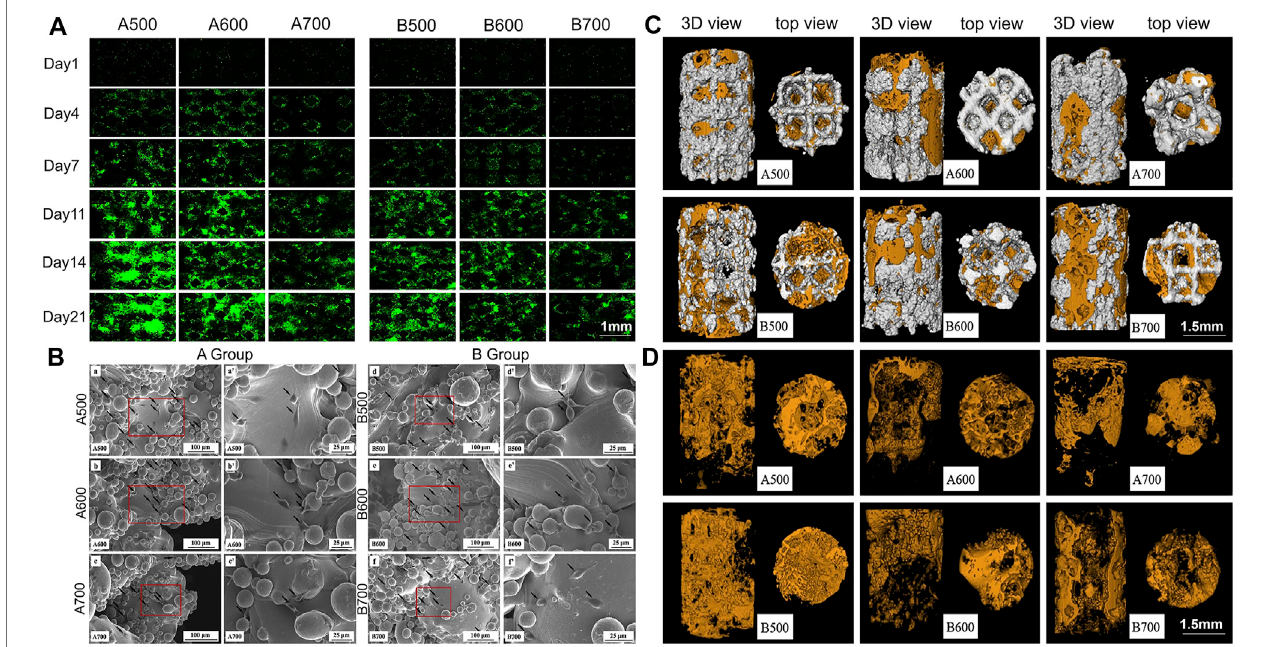
FIGURE 3 | (A) Fluorescent images showing cell proliferation on the porous scaffolds. (B) Scanning electron microscopy (SEM) observation of rat BMSCs. Black arrows point to cells. (C) Micro-CT analysis of new bone formation. Reconstruction images of porous implants; (D) Reconstruction images of bone formation. Orange area: new bone formation. Reprinted with permission from (Chen et al.,